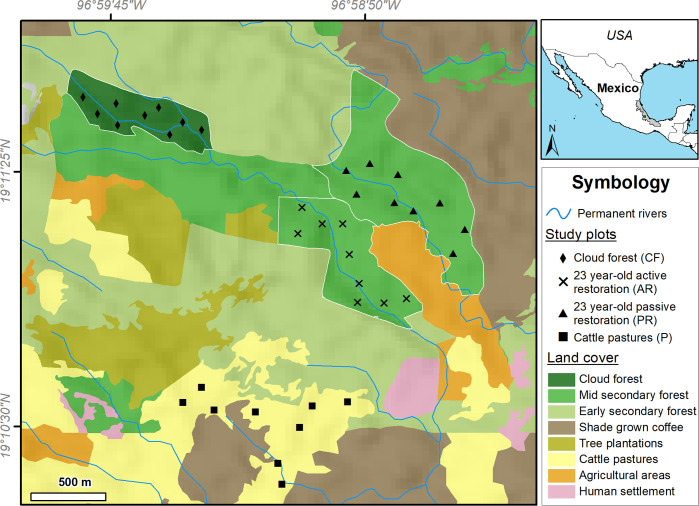
Map showing the study area, land-cover types, and the location of 36 study plots (black markers) in four vegetation types studied in the mountainous region of central Veracruz, Mexico.Tree plantations include monocultures of bamboo, avocado and pine.